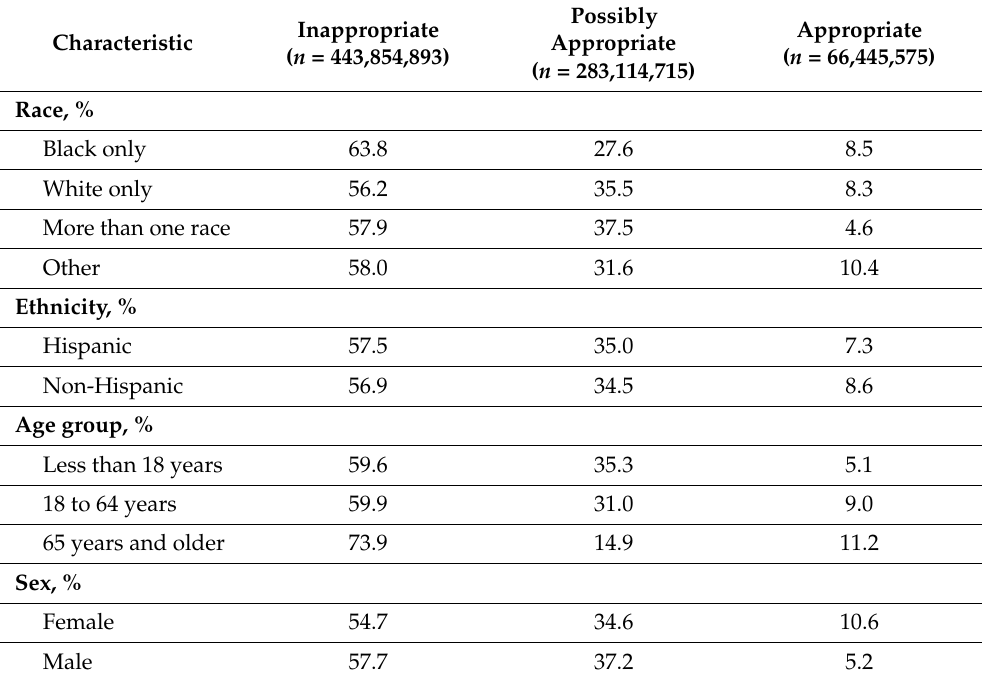
Table 1. Disparities in inappropriate antibiotic prescribing by patient subgroup.